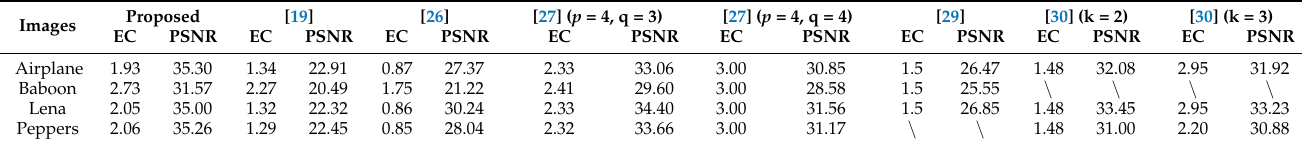
Table 3. Comparison of PSNR and EC with related